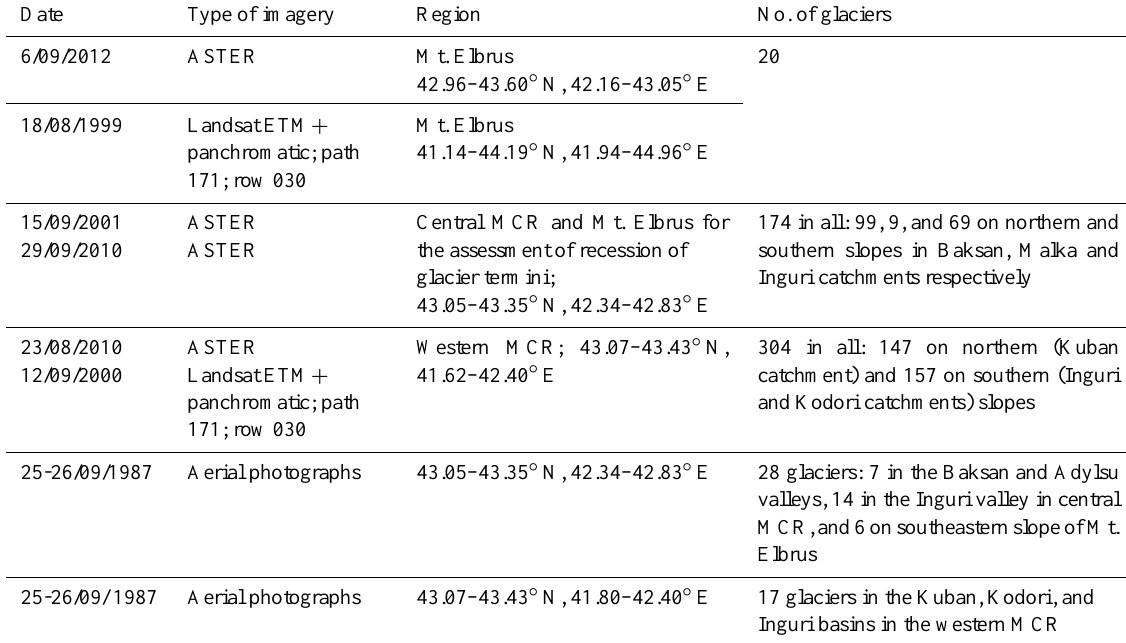
Table 1. Details of the imagery used for glacier mapping. Location of catchments are shown in Fig.